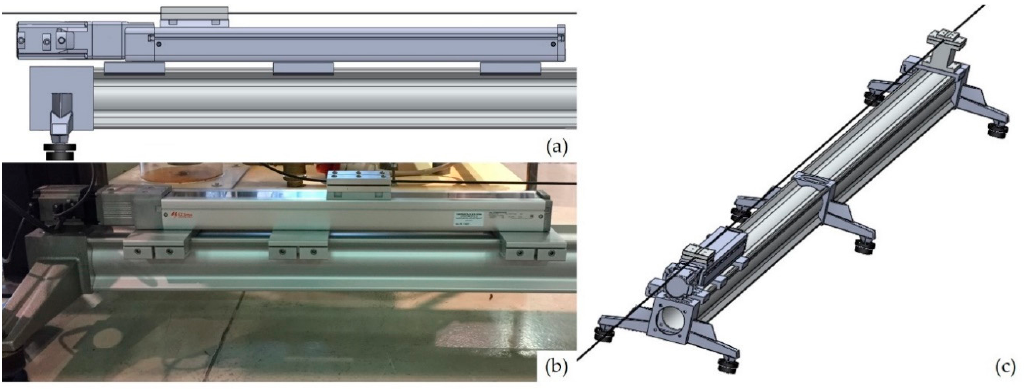
Figure 4. Linear actuator schematic ( a ) and picture ( b ); test rig assembly representation ( c